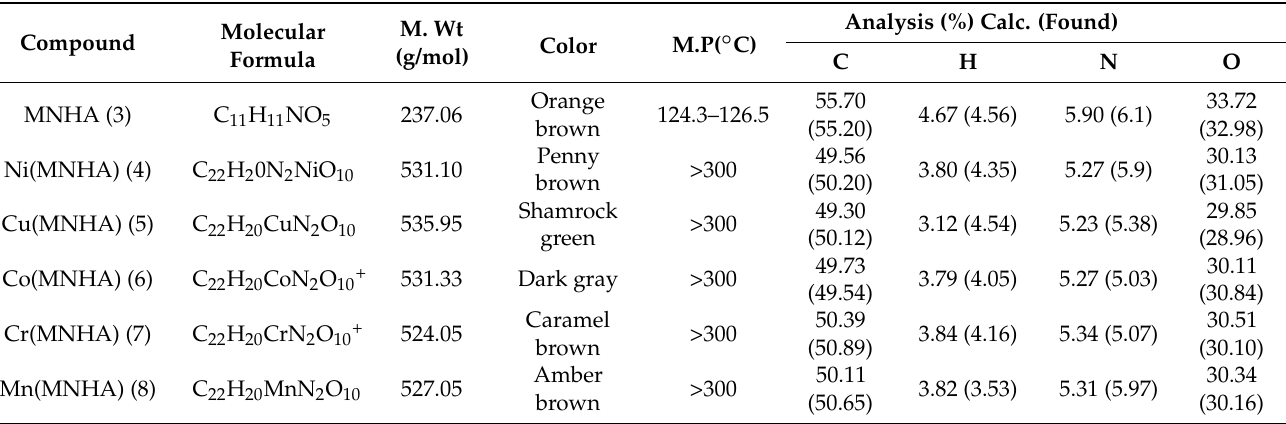
Table 1. Physical and analytical data of compounds 3 – 8